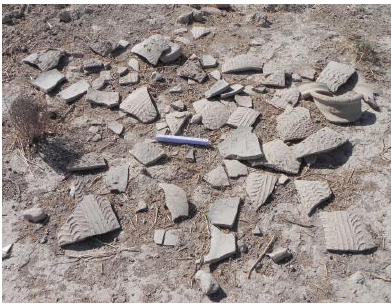
unknown person from a small illicit excavation (see Figure 5).